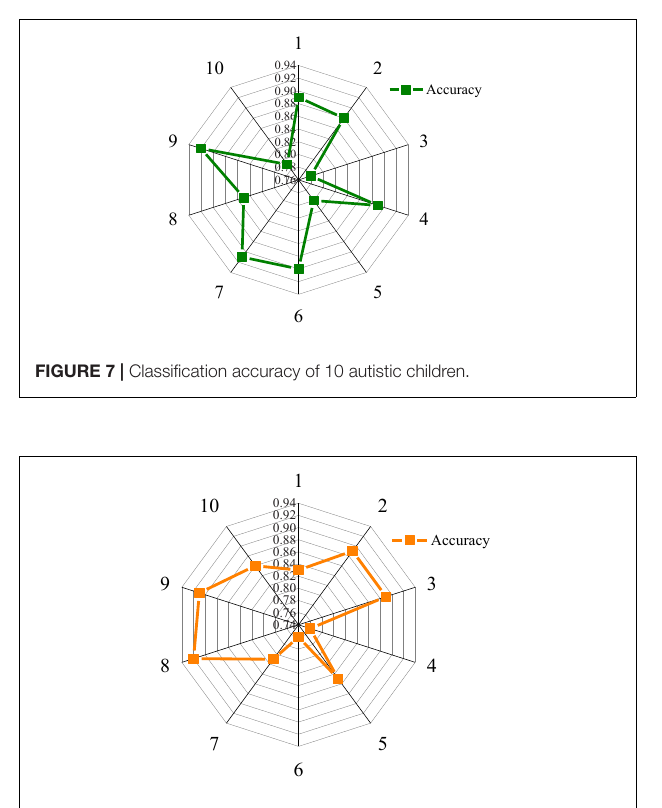
FIGURE 8 | Classification accuracy of 10 healthy